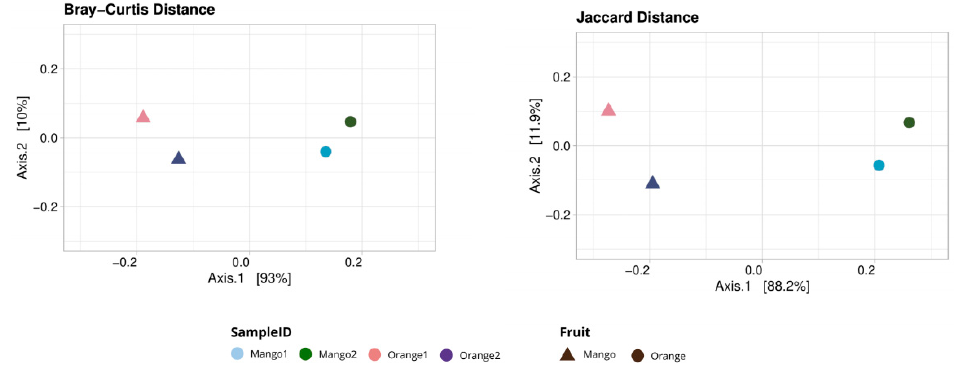
Figure 1. Principal Coordinate Analysis (PCoA) of beta diversity using a Bray–Curtis and Jaccard distance from microbial communities of fruits (Mango and Orange) and their technical replicates, represented in a non-metric multidimensional scaling (NMDS). The blue and green dots refer to the Mangoes and their replicates. The pink and purple triangles refer to the Oranges and their replicates.